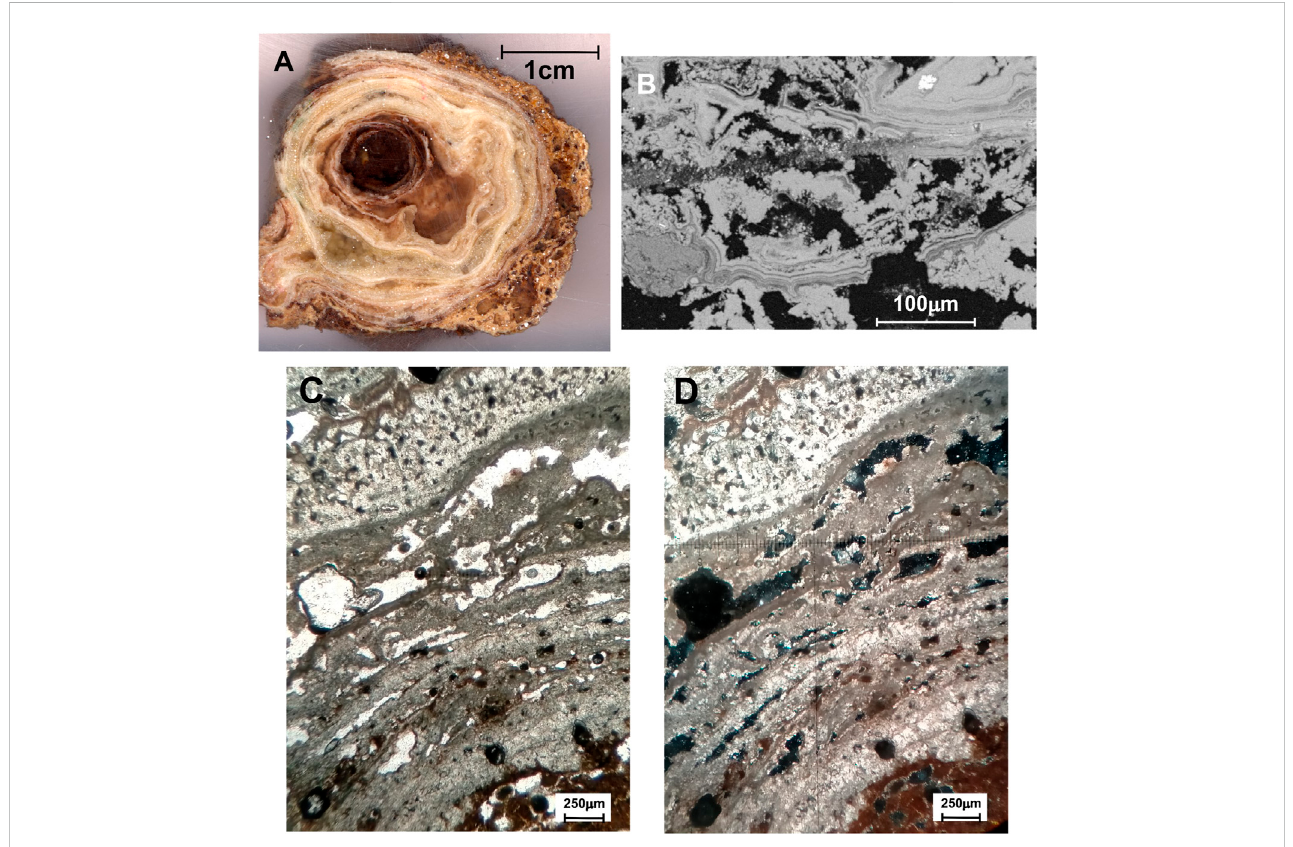
FIGURE 10 Reedtravertine. (A) Polishedslabwiththeplantcast fi lledwithdetriticmaterialinthecentralzoneandconcentriccarbonateprecipitation. (B) SEMimage showing calcite crystal laminae composed of vertical arborescent structures alternating with micritic levels. We can also observe recrystallization bands crossingthesample (CandD) Thinsectionwithparallelandcrossednicolsrespectively.Weobservedhighporosityandthecarbonategrowthwithconcentric disposition alternating with detrital